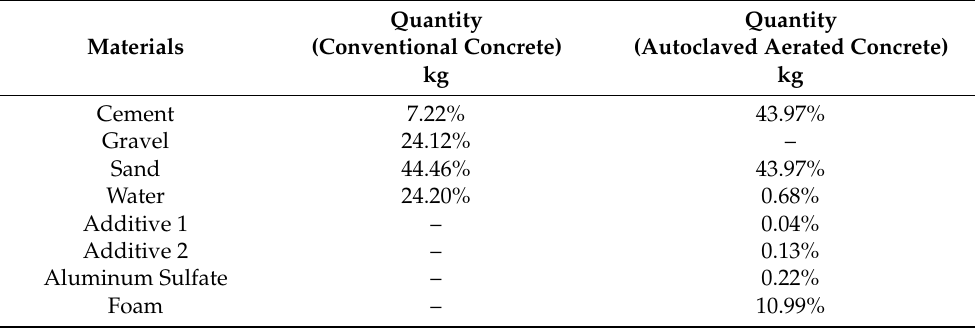
Table 1. Percentage dosage of conventional and autoclaved aerated concrete mix.